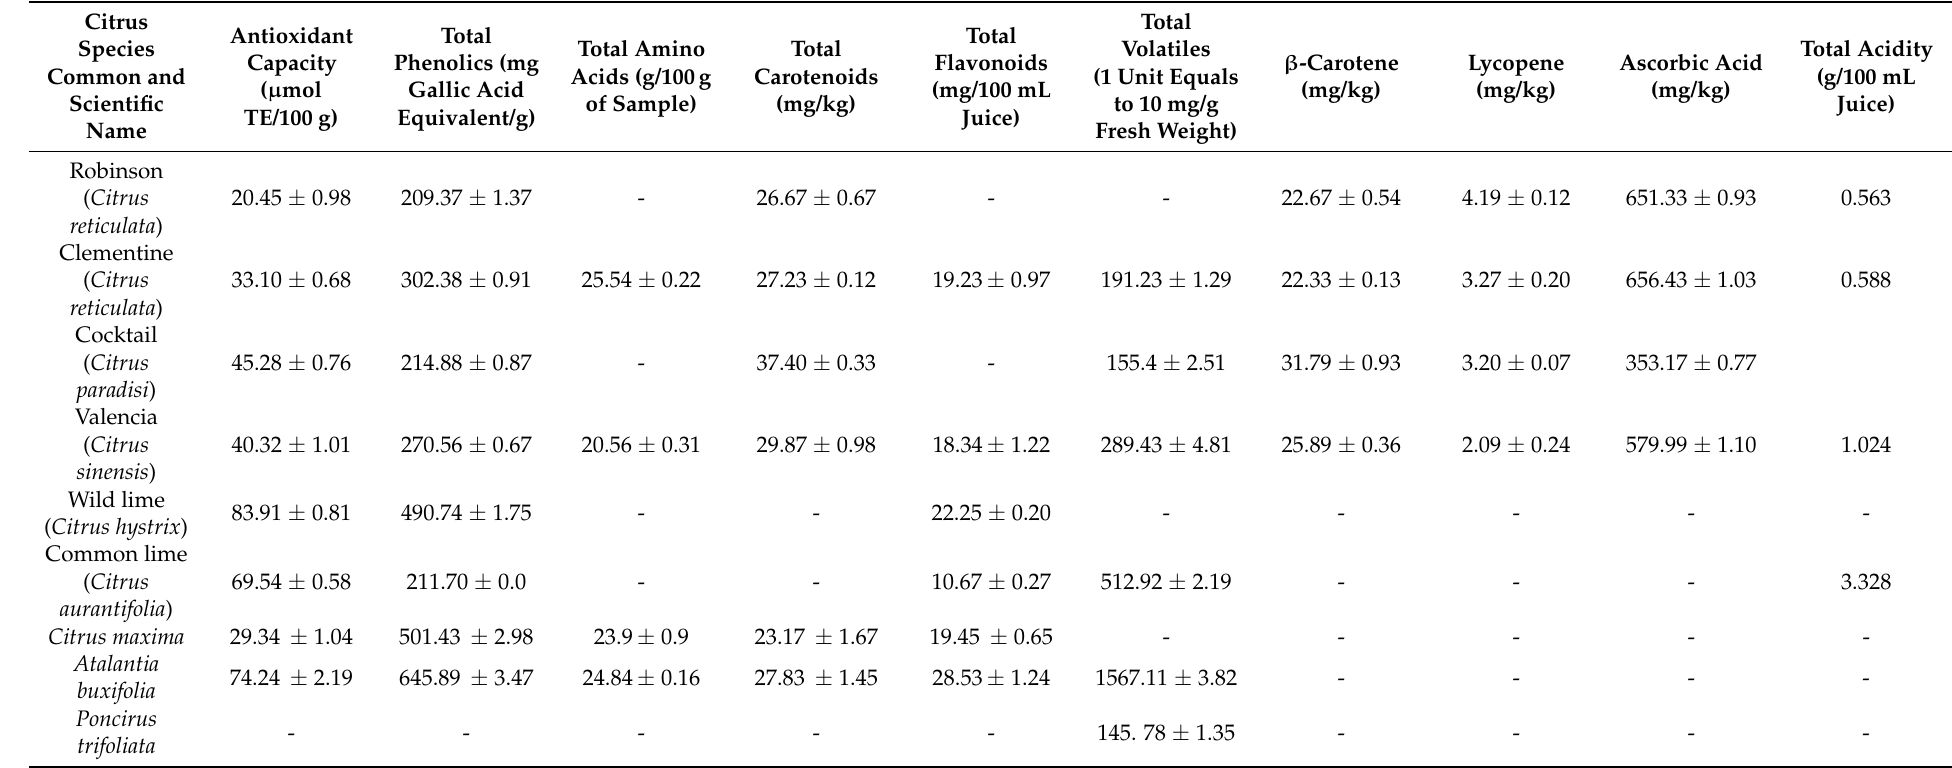
Table 3. The average amount of bioactive compounds and antioxidant capacity of different Citrus species